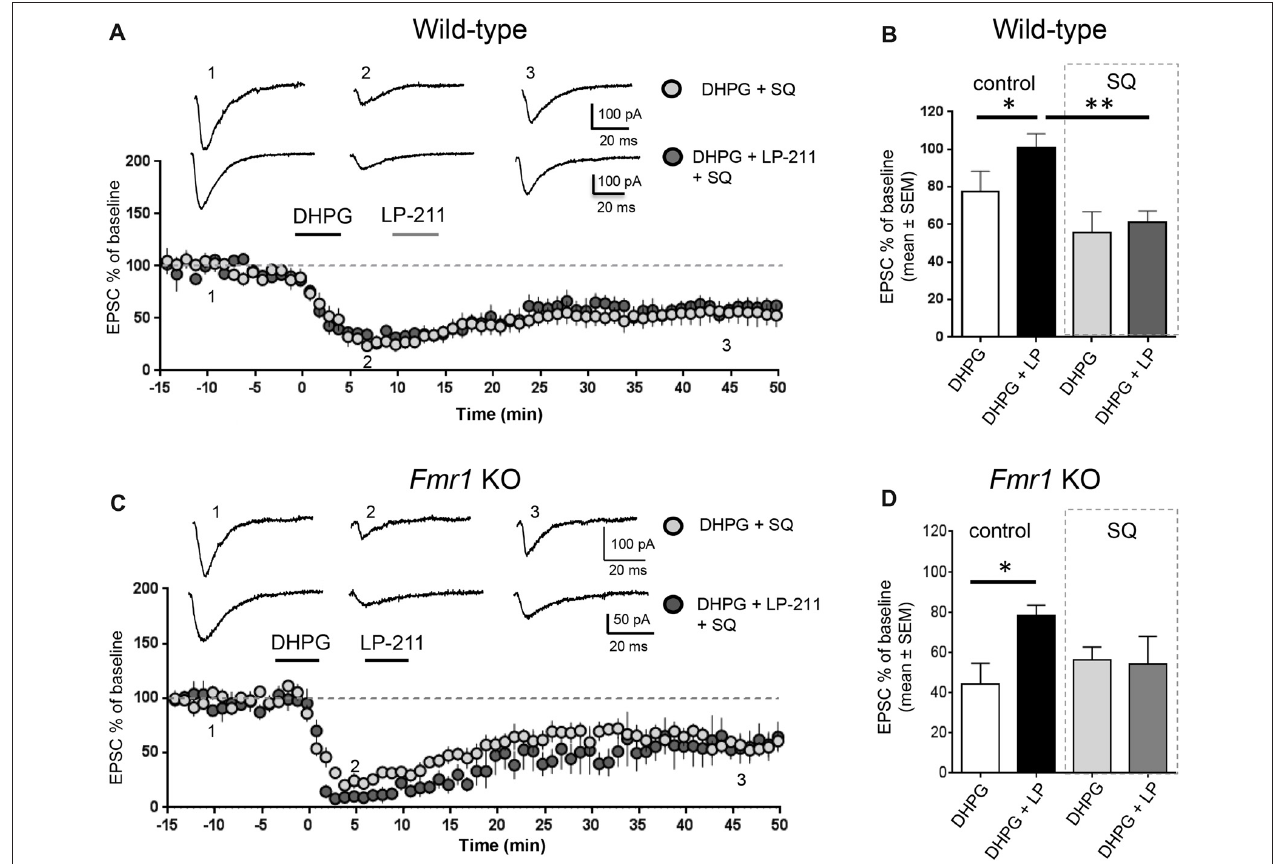
FIGURE 3 | Activation of 5-HT 7 receptors reversed mGluR-LTD by stimulation of adenylate cyclase. (A) In hippocampal WT slices, application of LP-211 did not modify mGluR-LTD in the presence of the adenylate cyclase blocker SQ 22536 (10 µ M, included in intracellular pipette solution; dark gray dots, n = 6). (B) The bar graph shows the amount of mGluR-LTD measured 45 min after LTD induction (mean EPSC amplitude in all tested neurons, expressed as % of baseline EPSC amplitude). In WT slices, bath applications of DHPG-induced mGluR-LTD (white column; n = 11) that was completely reversed when DHPG application was followed by application of the 5-HT 7 R agonist LP-211 (10 nM, 5 min; black column, n = 7; ∗ P = 0.03 by unpaired t -test). In the presence of intracellular SQ 22536 (10 µ M; gray column, n = 6), the amount of mGluR-LTD was slightly increased with respect to control and was not reversed by application of LP-211 (10 nM, 5 min; dark gray column, n = 6; significantly different from the effect of LP-211 in control conditions, ∗∗ P = 0.0026 by unpaired t -test). (C) Similarly, in Fmr1 KO slices application of LP-211 (10 nM, 5 min) had no effect on mGluR-LTD in the presence of intracellular SQ 22536 (10 µ M; dark gray column, n = 6). (D) In Fmr1 KO slices, application of LP-211 reversed DHPG-induced mGluR-LTD only in control conditions (black column, n = 6; ∗ P = 0.02 by unpaired t -test) but not in the presence of SQ 22536 (SQ, 10 µ M; gray column, n = 6), showing that 5-HT 7 R-mediated effect required stimulation of adenylate cyclase also in Fmr1 KO